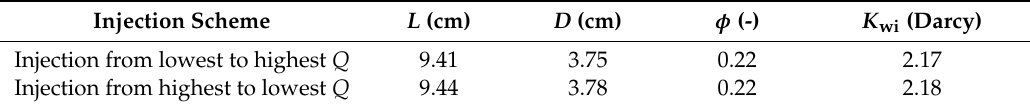
Table 2. Properties of cores used for hysteresis investigation of polymer injection scheme. Injection